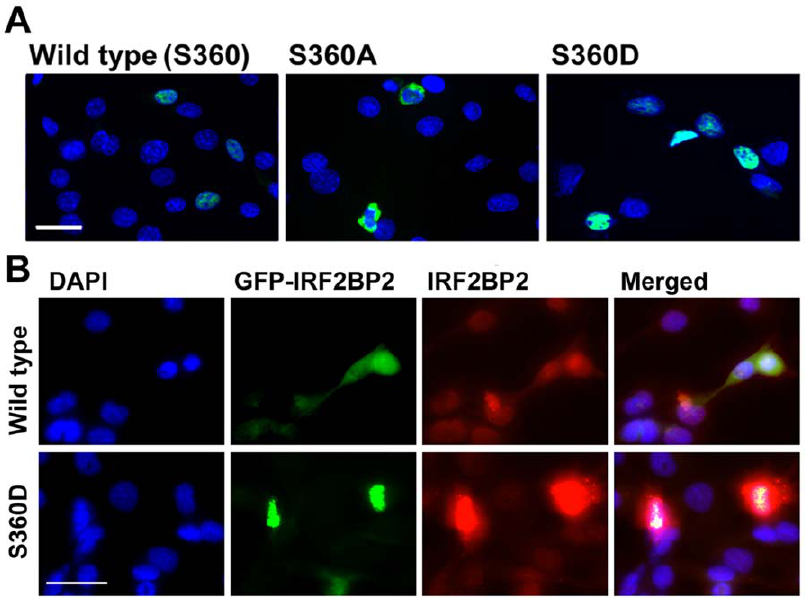
Figure 4. Phosphorylation of serine 360 controls nuclear localization of IRF2BP2 . A. Site-directed mutagenesis of serine 360 to alanine (S360A) blocked nuclear localization of IRF2BP2 whereas aspartic acid substitution (S360D) did not differ from wild type and was nuclear localized